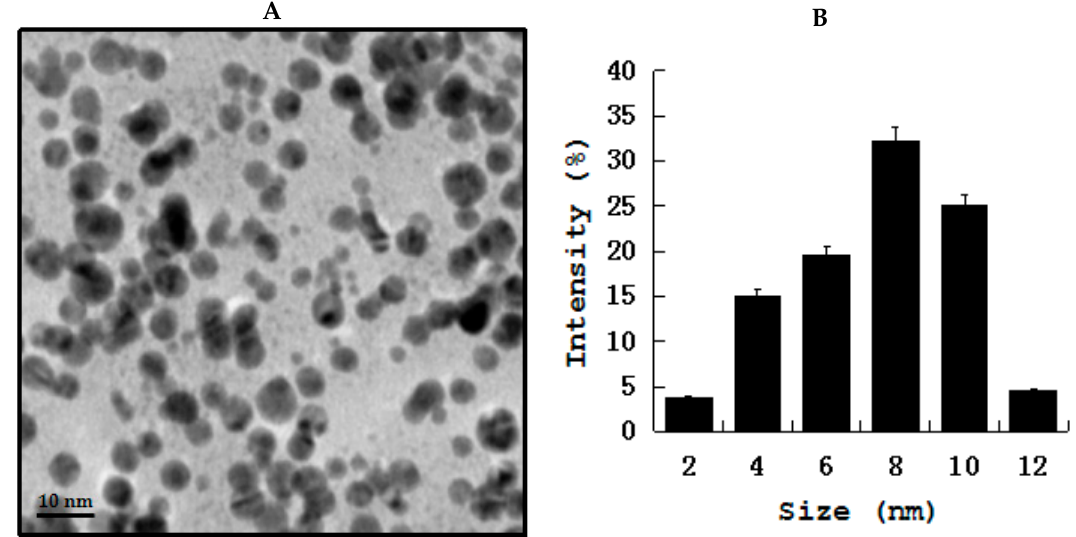
Figure 4. ( A ) TEM images of AuNPs ( B ). Size distribution of AuNPs from TEM images. TEM images of several fields were used to measure AuNPs particle size; micrographs (left panels); and, size distributions based on TEM images (right panels) of AuNPs ranging from 2 nm to 12 nm.